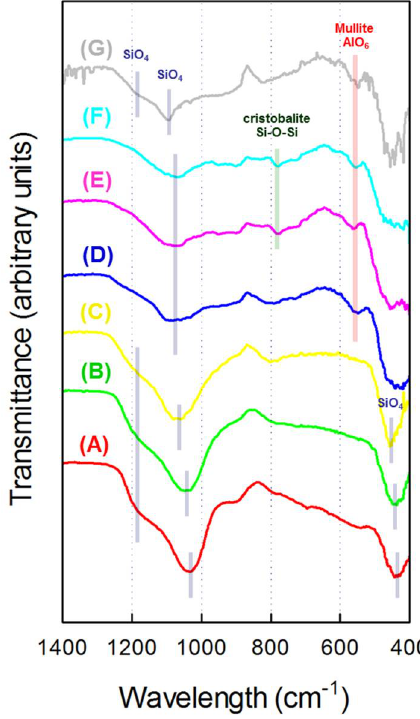
Figure 6. FT-IR spectra of the silica-alumina nanoparticle precursor after calcination at different temperatures: ( A ) as prepared; ( B ) 500 °C; ( C ) 800 °C; ( D ) 950 °C; ( E ) 1150 °C; ( F ) 1250 °C, and ( G ) 1500 °C.